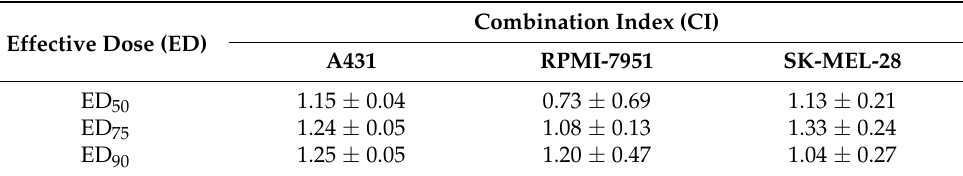
Table 6. Combination studies of cytotoxic effects of ( E )- and ( Z )-guggulsterones in human skin cancer cell lines. Combination index (CI) at three guggulsterone effective doses was analyzed by XTT in cells treated for 72 h. All data were mean ± SEM of three biological samples, each analyzed in triplicates. Effective Dose (ED)